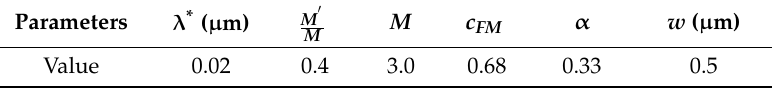
Table 4. Parameters for the hardening model of DP600 steel